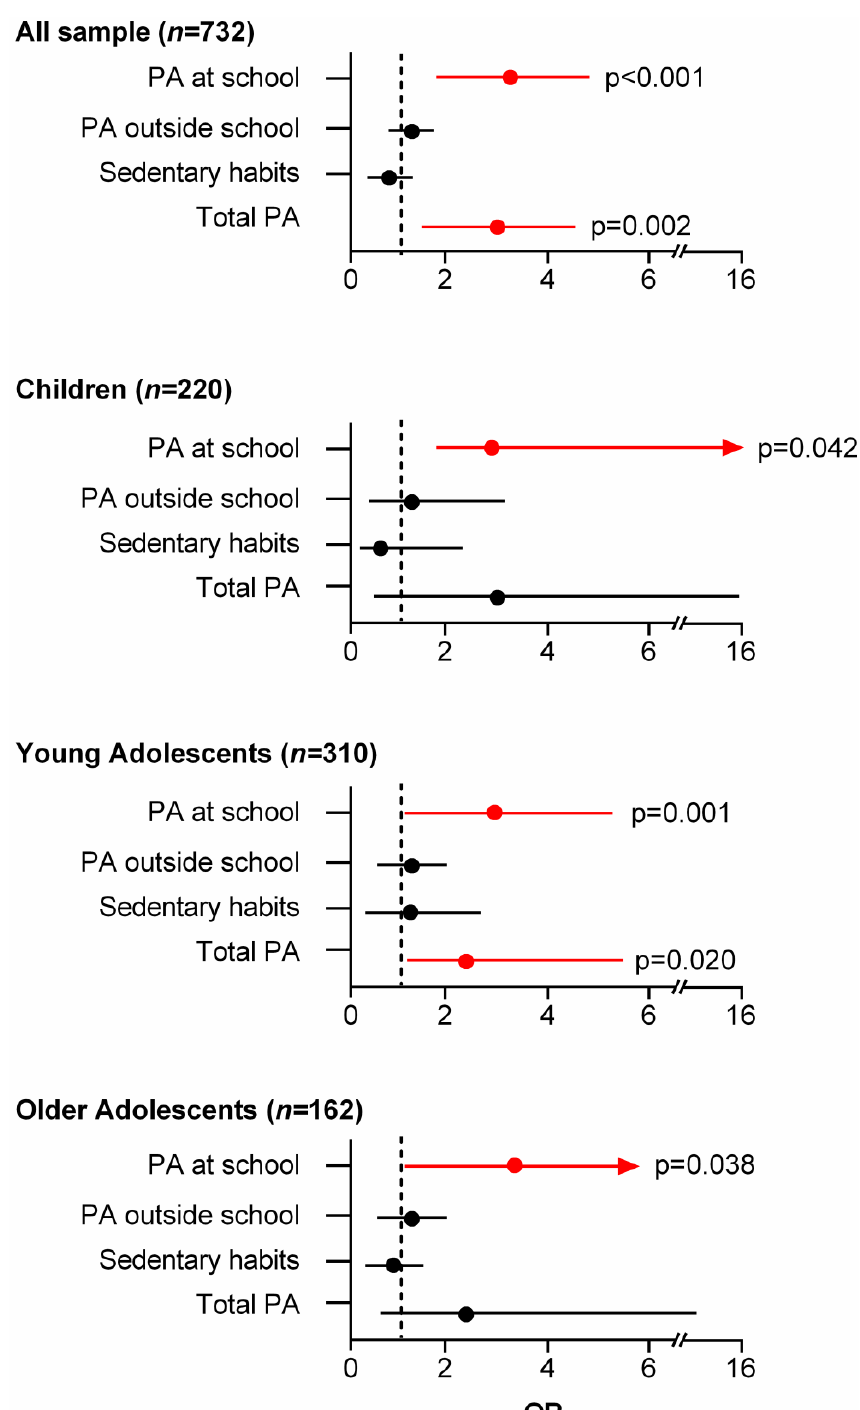
Figure 3. Association between be active commuting to and from school and YAP-Q categories for the whole sample and by age groups. Red arrows indicate significant association.